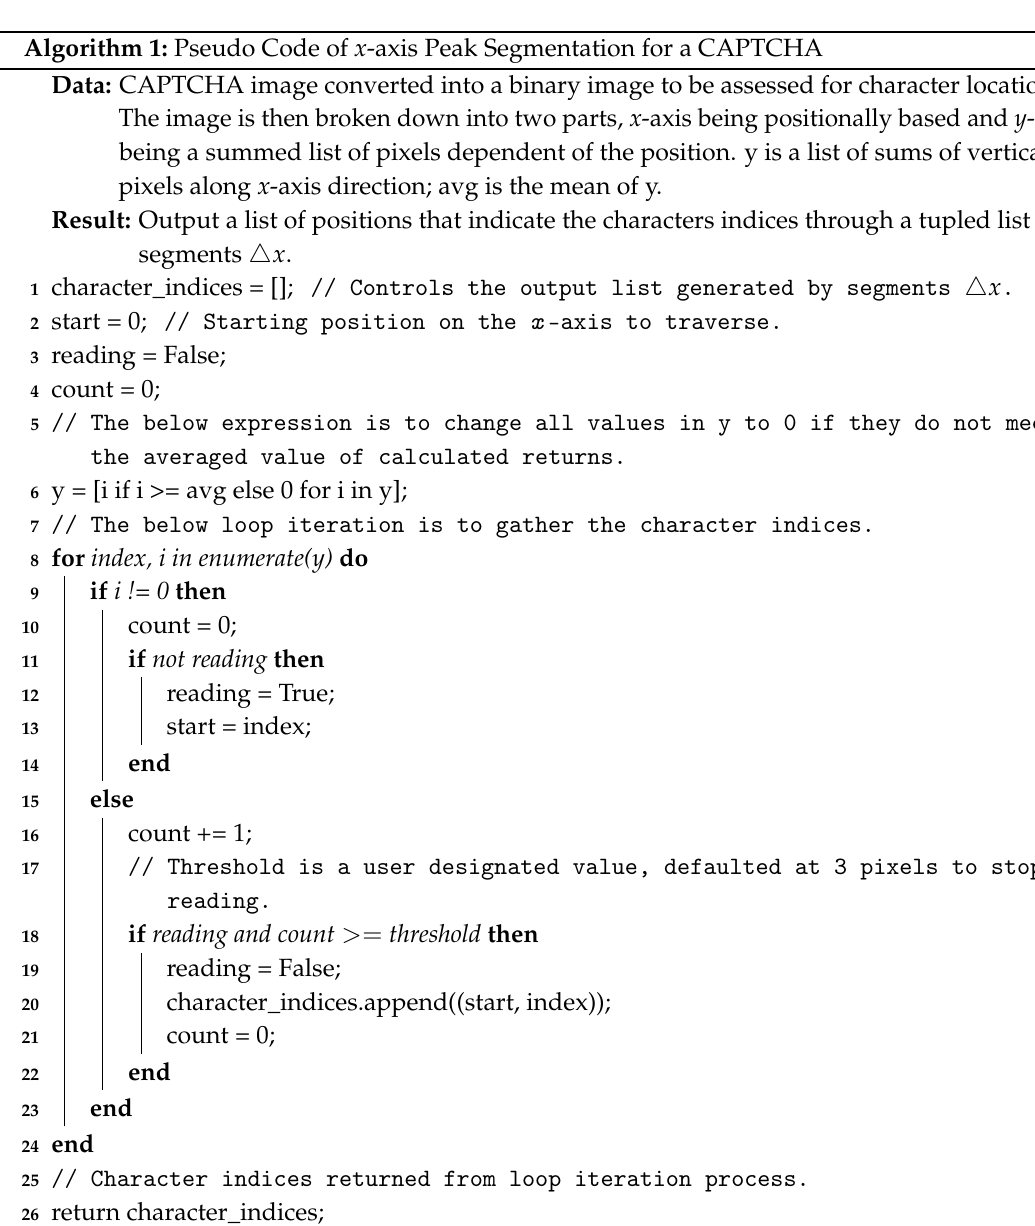
Algorithm 1: Pseudo Code of x -axis Peak Segmentation for a